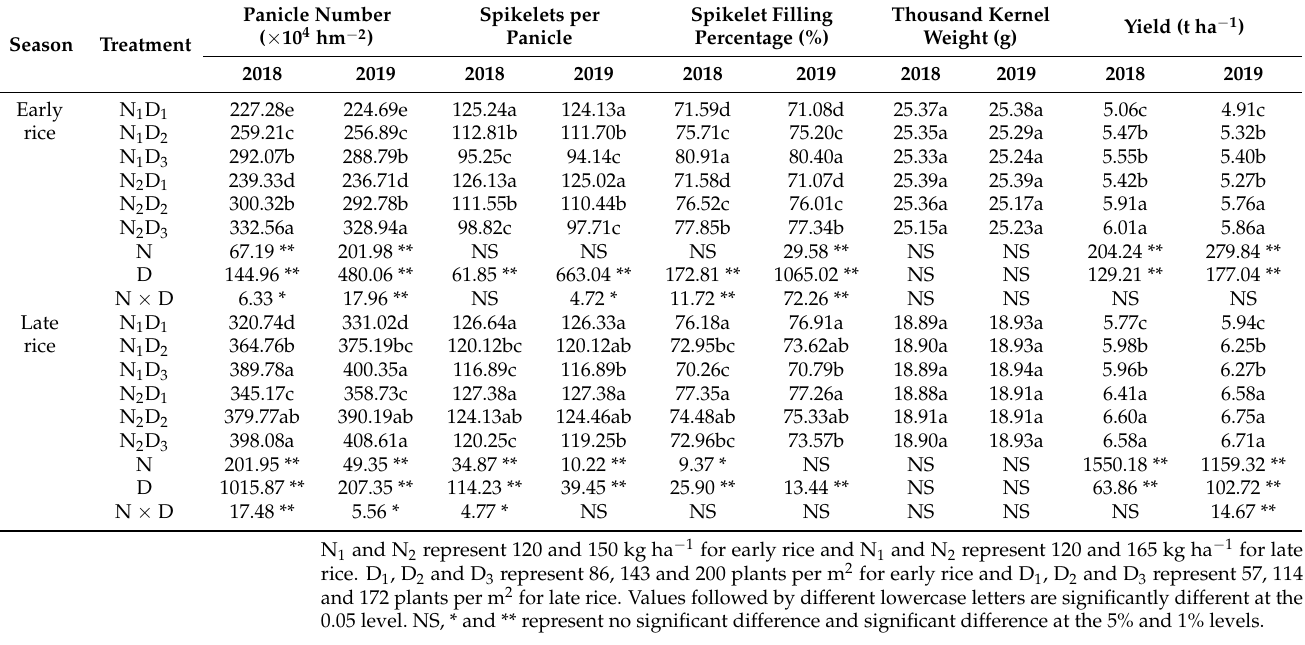
Table 2. Double cropping rice yield and yield compositions response to the N rate and plant density at Xingguo in 2018 and 2019.